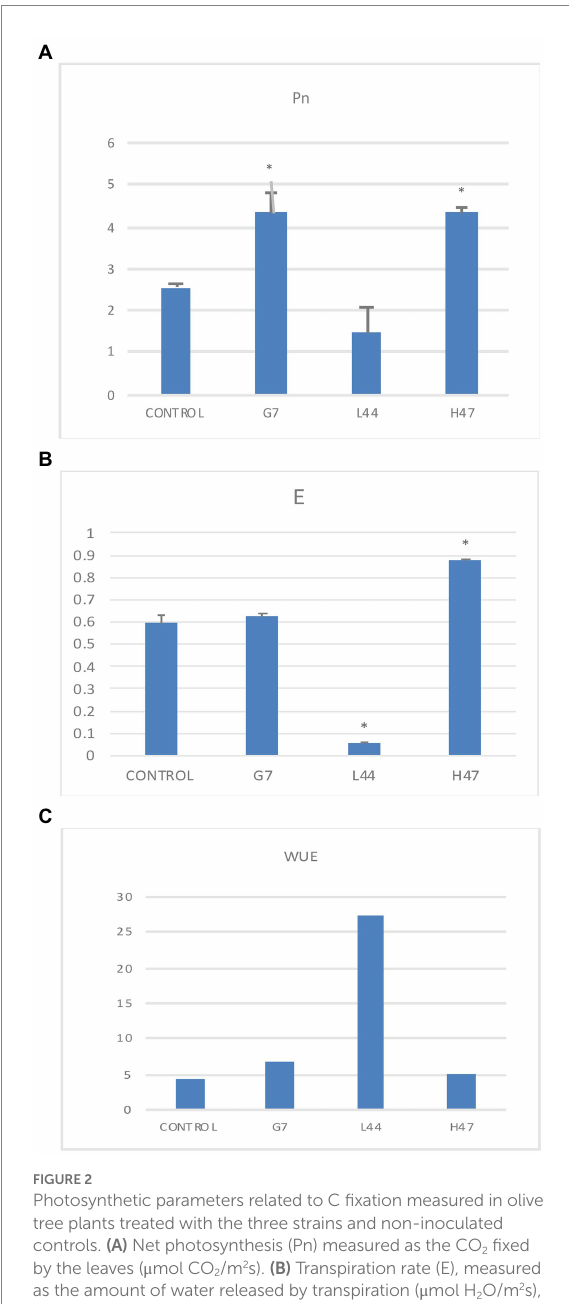
FIGURE 3 Photosynthetic pigments concentration ( μ g/g FW). (A) Chlorophyll a, (B) Chlorophyll b, and (C) Carotenoids measured in olive tree leaves treated with the three strains. For each treatment and parameter average value ±SE value is presented ( n = 6). Asterisks ( * ) represent significant differences with the control according to the T student test ( p <